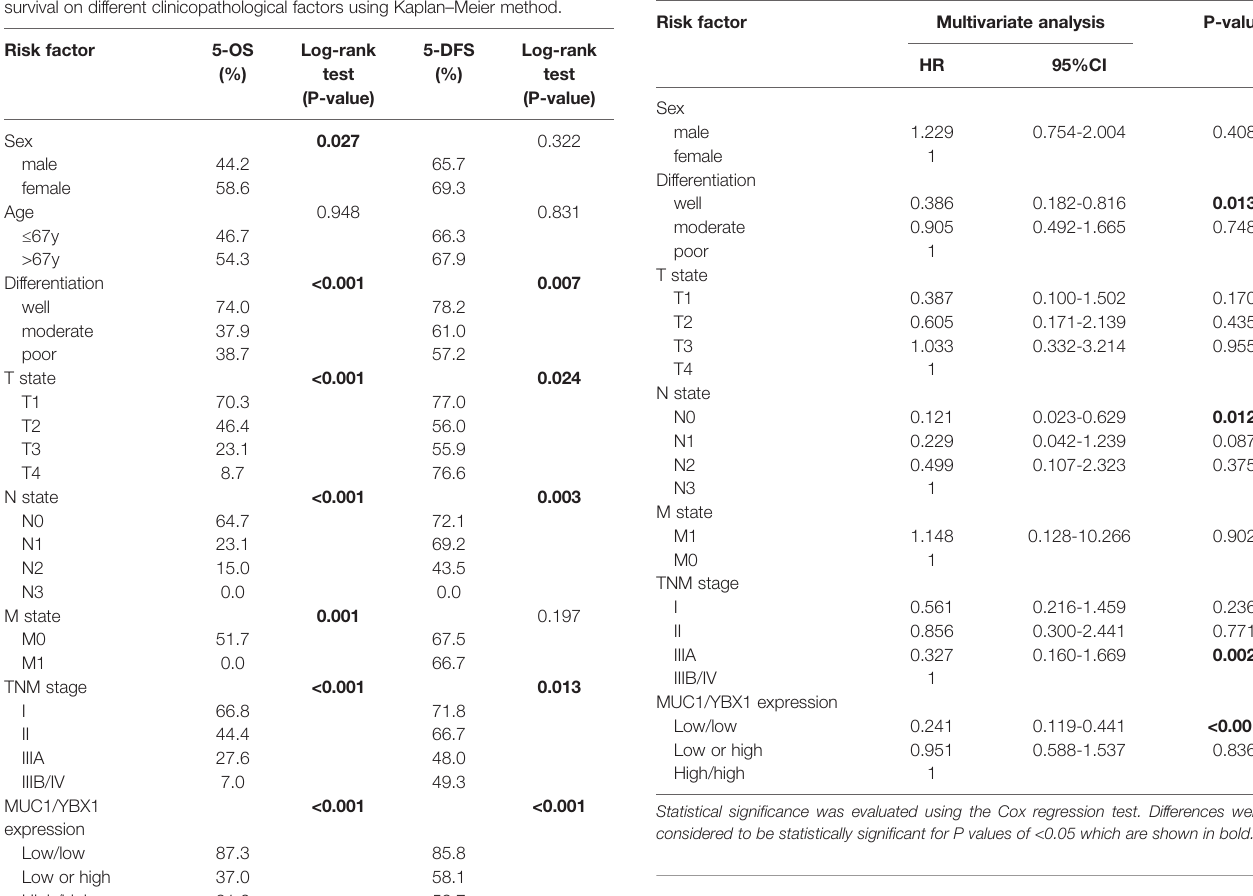
TABLE 5 | Multivariate analysis of disease-free survival using Cox